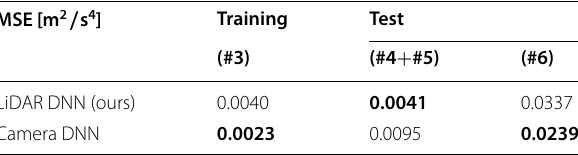
Bold value represents the best result in each experiment/validation Table 4 MAE and variance of static estimation on synthetic data MAE [deg] {Var. [ deg 2 ]}